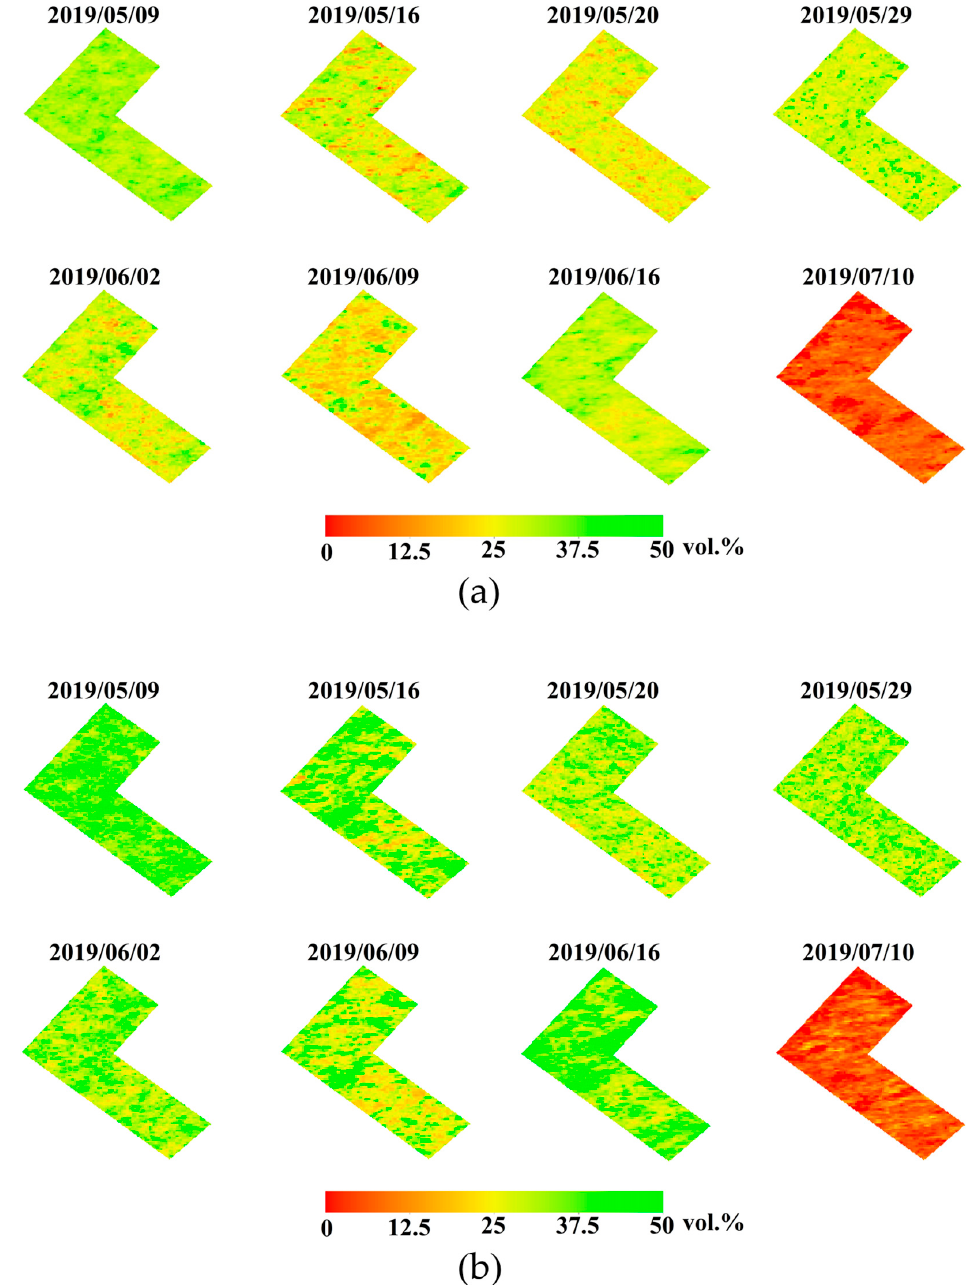
Figure 14. Soil moisture maps of the study area; ( a ) Ratio method; ( b ) WCM.